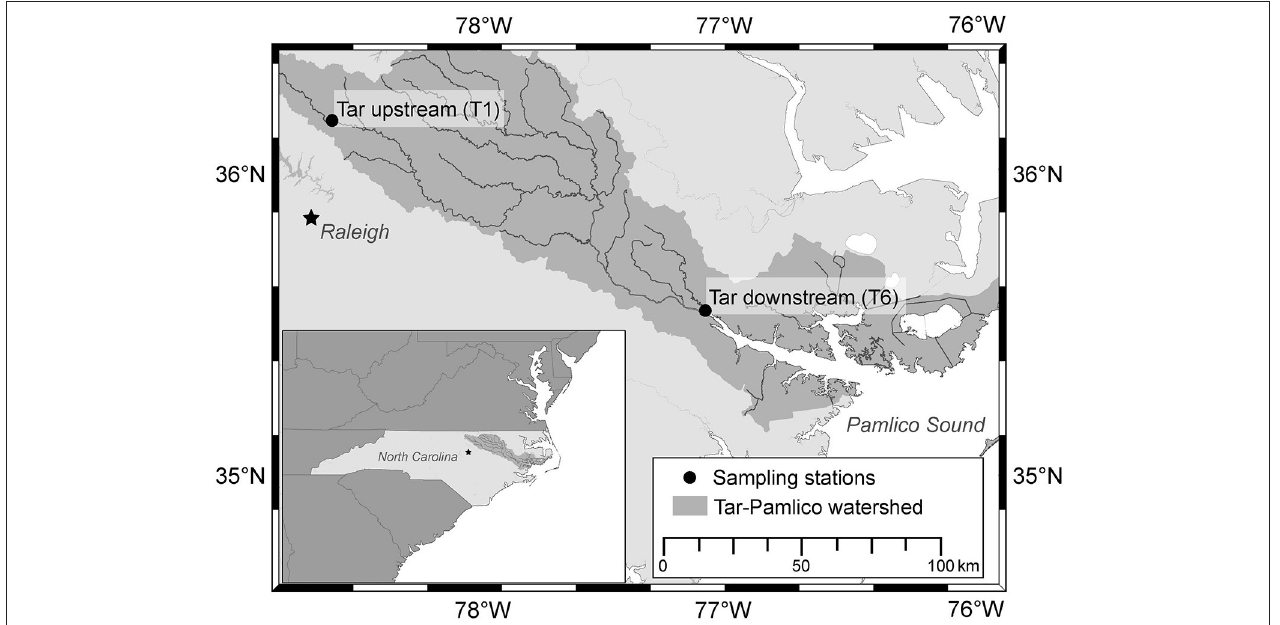
FIGURE 1 | Tar River Watershed showing the upstream and downstream sampling sites, T1 and T6, respectively. The inset shows the location of the Tar-Pamlico watershed within North